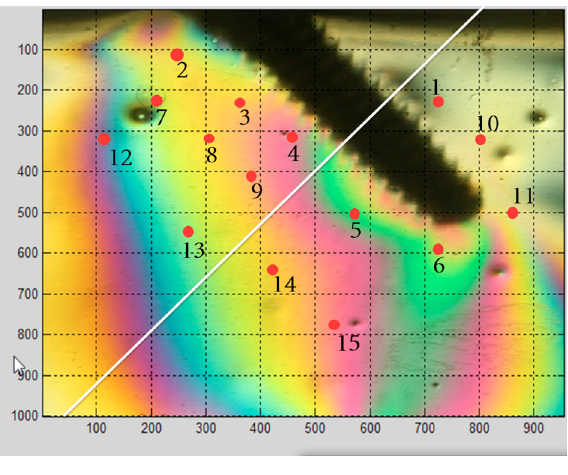
Figure. 2: Pre-determinate points around the implant in the apical and cervical region.